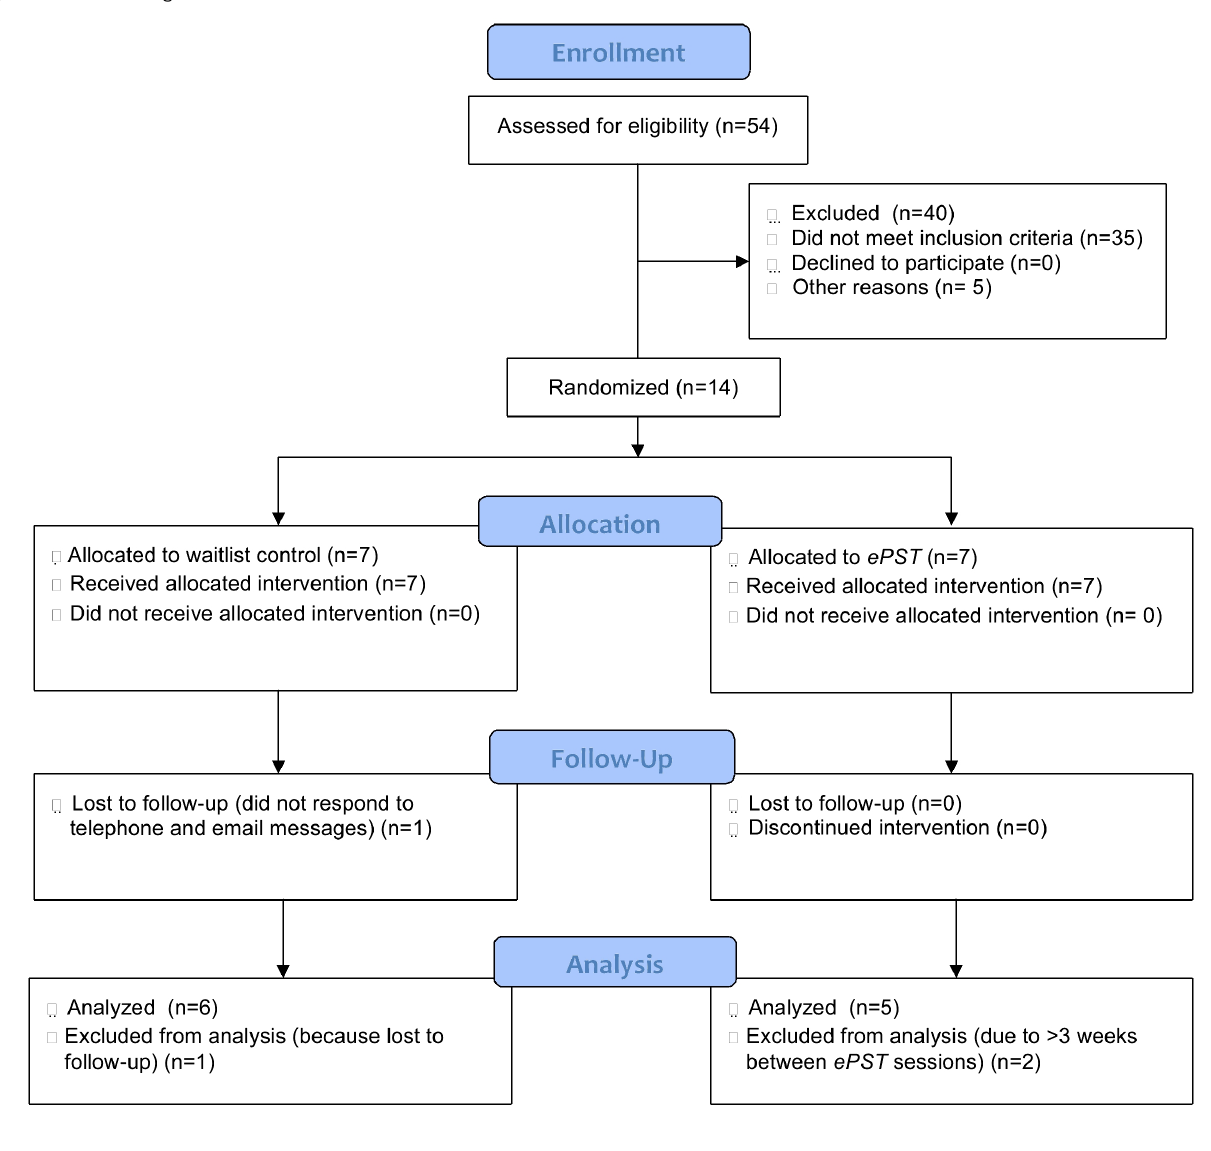
Figure 2. Consort diagram.